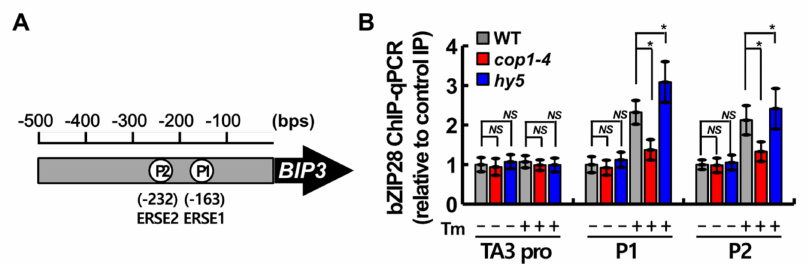
Figure 5. Analysis of the binding of bZIP28 to the BIP3 promoter in WT, cop1-4 , and hy5 plants by ChIP assay. ( A ) Schematic representation of the BIP3 promoter showing the location of the two ERSE motifs. P1 and P2 represent the respective primer positions used for ChIP-quantitative PCR (qPCR). ( B ) ChIP-qPCR analysis of the binding of bZIP28 to the BIP3 promoter. ChIP assays were performed using 10-day-old WT (Col-0) and cop1-4 seedlings treated with Tm (+) or dimethylsulfoxide (DMSO; control) ( − ) for 6 h. DNA–protein complexes were immunoprecipitated using antibodies against bZIP28 and rabbit IgG (negative control). ChIP DNA was quantified by qRT-PCR, with primers specific to the ERSE motifs (P1 and P2) and TA3 promoter (control). Data represent mean ± SEM ( n = 3 technical replicates). Asterisks indicate statistically significant differences (Student’s t -test; * p < 0.05; NS , not